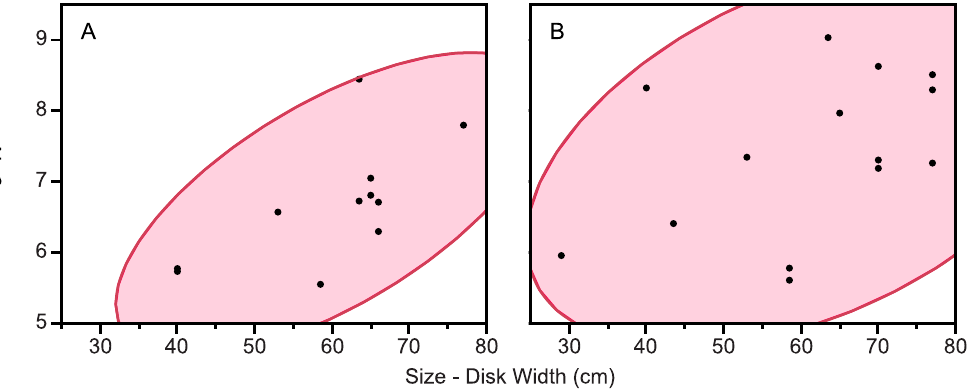
area calculation. Convex hulls presented a niche space for southern stingrays of 3.15, with 1.91 and 1.51 for nurse sharks and reef sharks respectively (Fig. 5A). Corrected Bayesian ellipse areas calculated D. americana niche space as 2.18 and G. cirratum and C. perezi as 0.88 and 1.23 respectively (Fig. 5B). D. americana